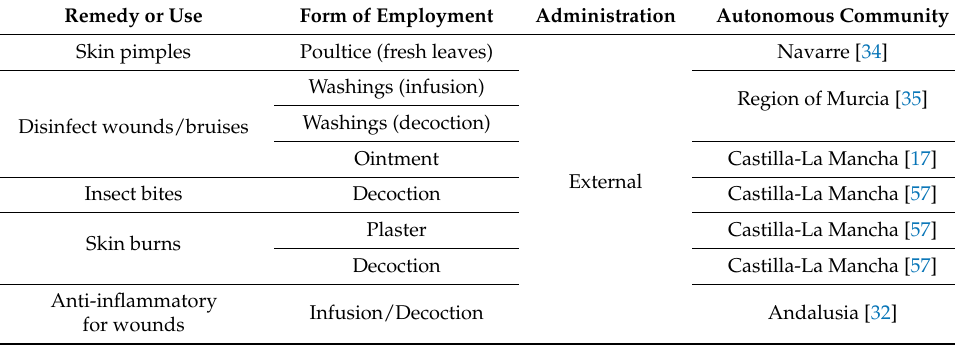
Table 7. Compilation of the medicinal uses of Chiliadenus glutinosus as a remedy for diseases of the integumentary system in Spain, compiled from the existing specific